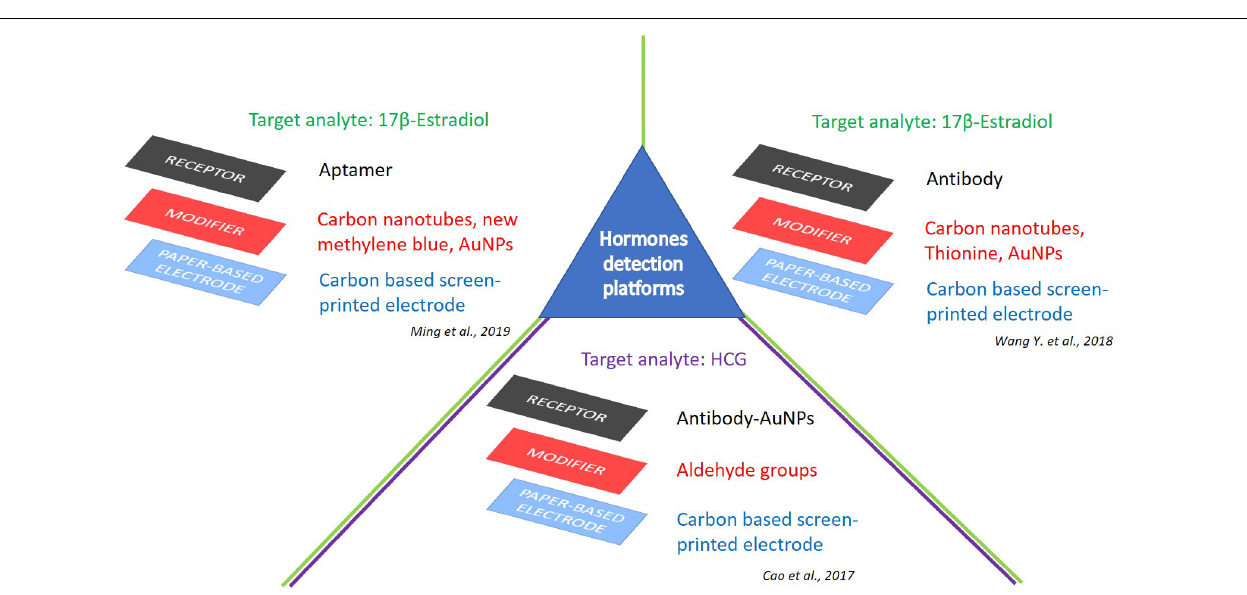
FIGURE 3 | e-PAD platforms for detection of hormones. Target analytes: 17 β -estradiol (Wang Y. et al., 2018; Ming et al., 2019), and HCG (Cao et al.,